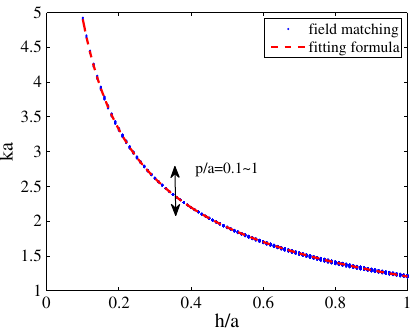
FIG. 16. Wave number by field matching algorithm (blue dots) and corresponding best fit to Eq. (A6) (red dashed line).